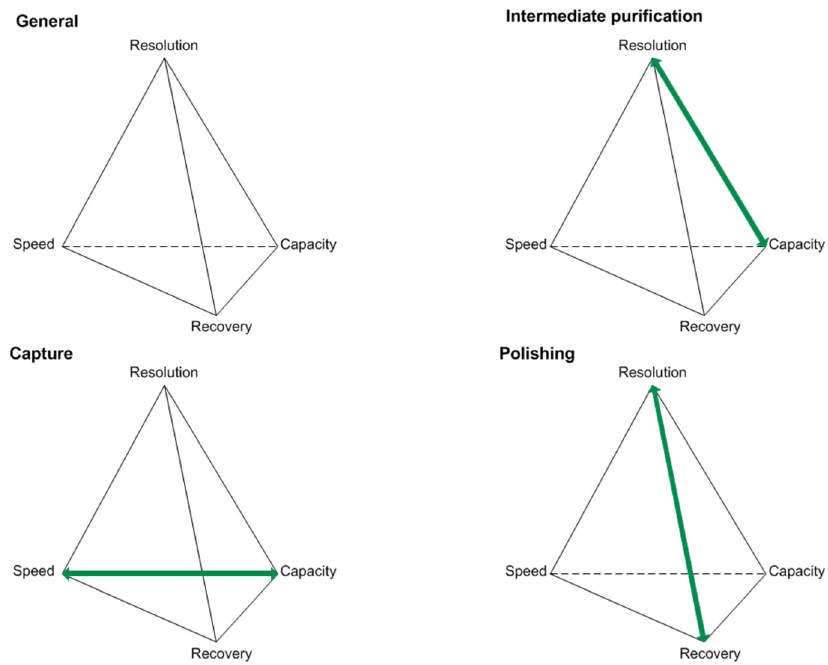
Figure 1. Key performance parameters of the capture, intermediate purification, and polishing step for protein purifications according to [18].